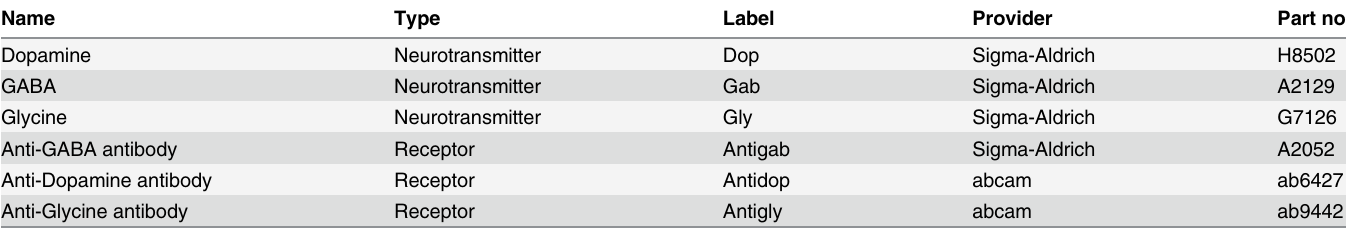
Table 2. List of the studied Neurotransmitters and